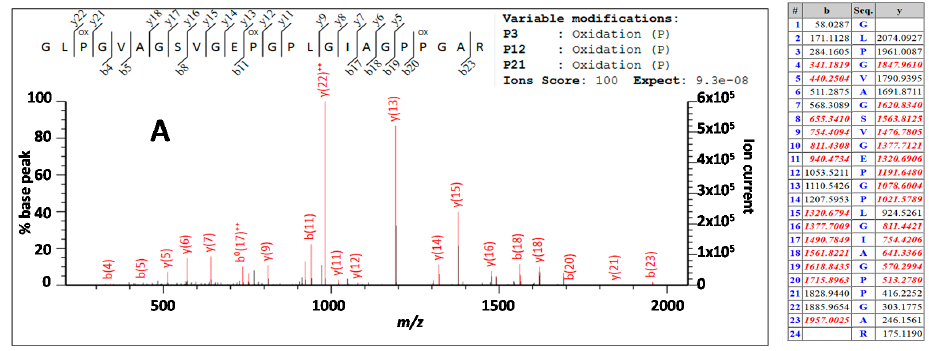
Figure 6. Cont. Figure 5. Cont